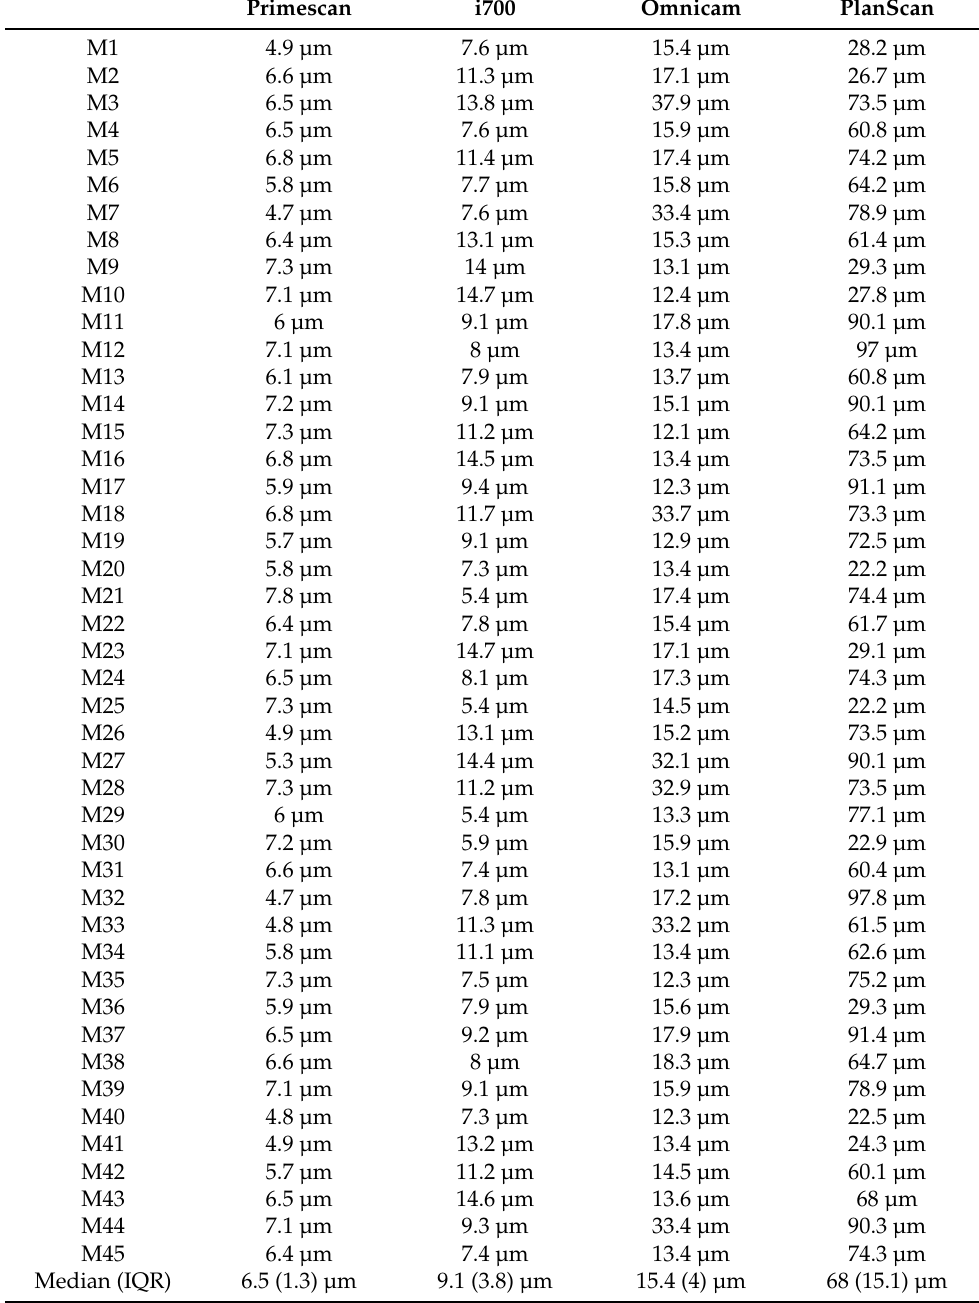
Table 3. Data obtained when comparing for